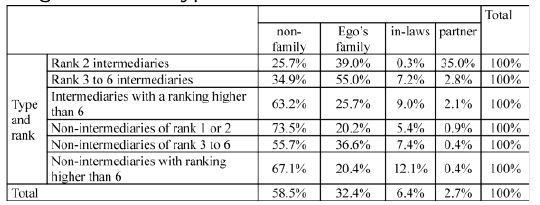
Table 3. Intermediaries by exit ranking assigned